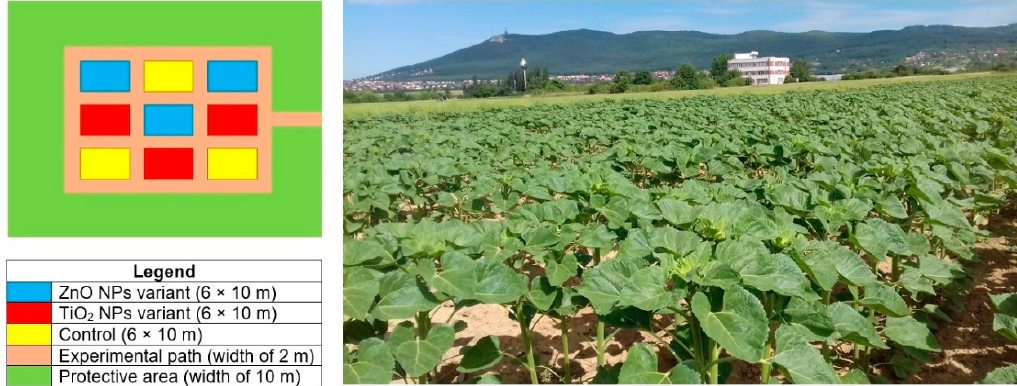
Figure 1. Schematic experimental field plant in aerial view.